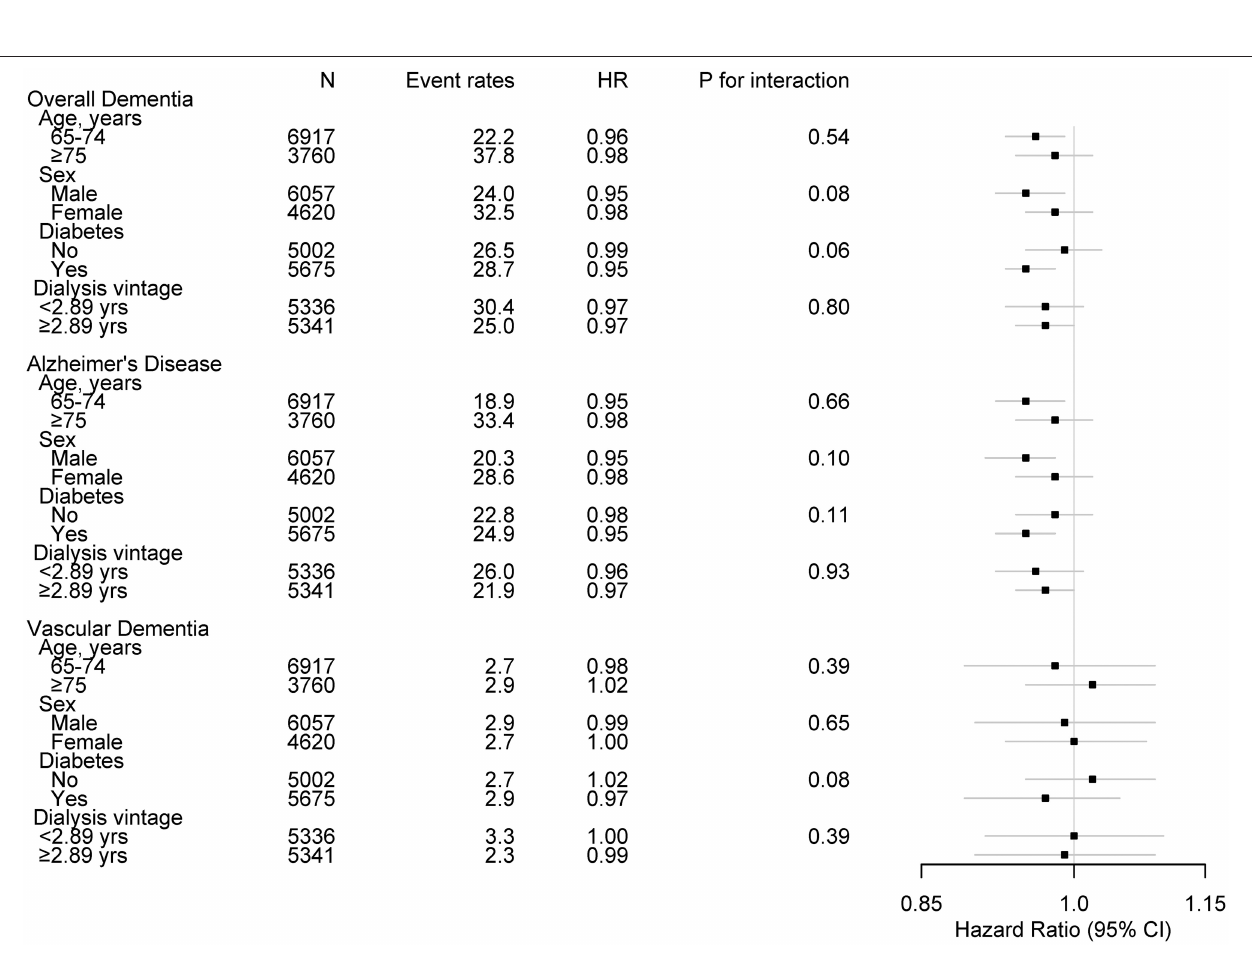
FIGURE 3 | Subgroup associations of Kt/V with incident dementia. Event rates are per 1,000 person-years. HR was calculated with spKt/V levels treated as continuous variable for development of dementia. HR was adjusted for age, sex, BMI, pre-dialysis SBP, economic status, cause of ESKD, dialysis vintage, vascular access type, CCI (except for diabetes and dementia), diabetes, hemoglobin, serum albumin, calcium, phosphorous, and use of IV iron or ESA. HR, hazard ratio; spKt/V, single-pool Kt/V; BMI, body mass index; SBP, systolic blood pressure; ESKD, end-stage kidney disease; CCI, Charlson comorbidity index; IV, intravenous injection; ESA, erythropoiesis stimulating